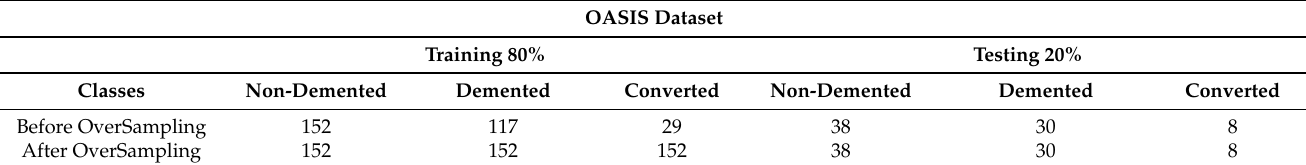
Table 3. OASIS dataset before and after the application of the SMOTE method.